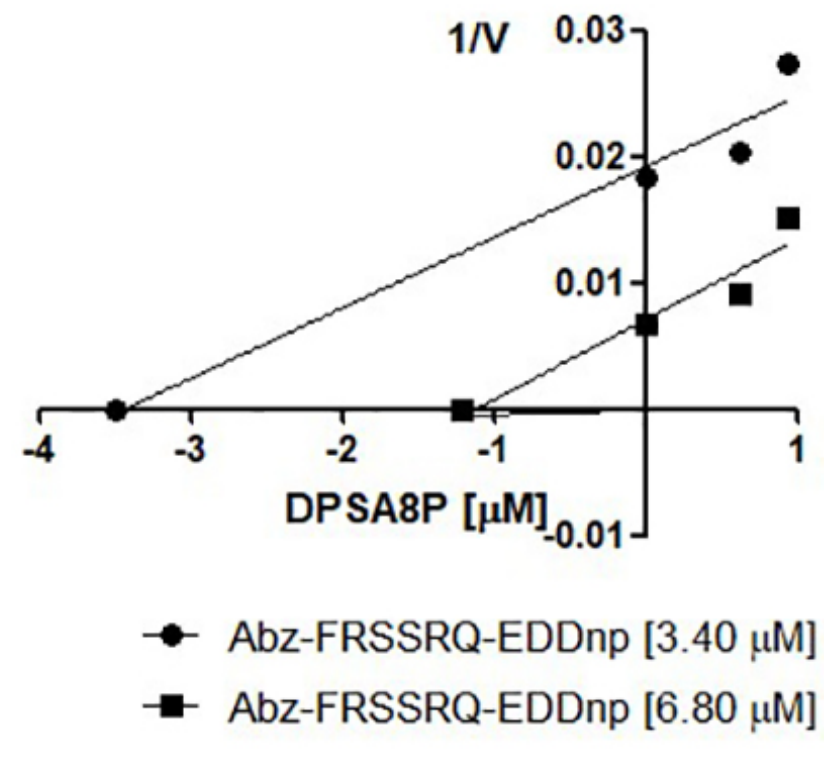
Figure 4. Dixon Plot built with the results of the inhibition assay of the elastase-1 activity over the FRET substrate Abz-FRSSRQ-EDDnp (3.40 and 6.80 µM), in the presence of the peptide (0.63 and 0.94 µM). The parallel lines indicate that there is the uncompetitive mechanism of inhibition. The inhibition constant was set as 8 µM. The graphic was made in the software GraphPad Prism